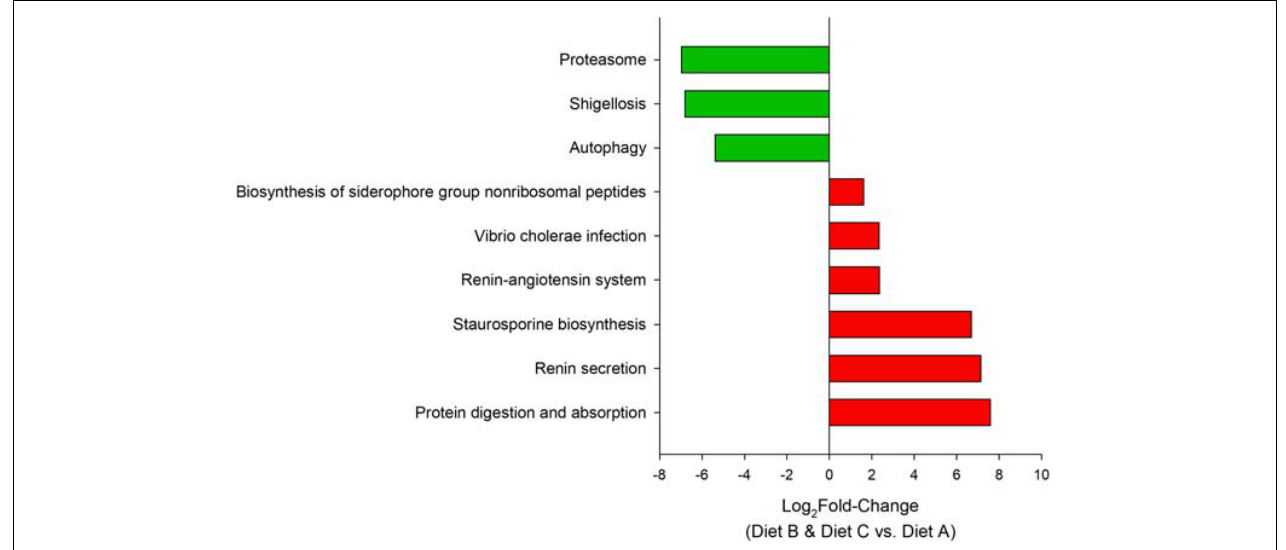
FIGURE 6 | Bar plots depicting the changes in metabolic capacities in the comparison between fish fed probiotic diets (B + C group) and fish fed the control diet A. Bars show the log 2 -fold change in the metabolic